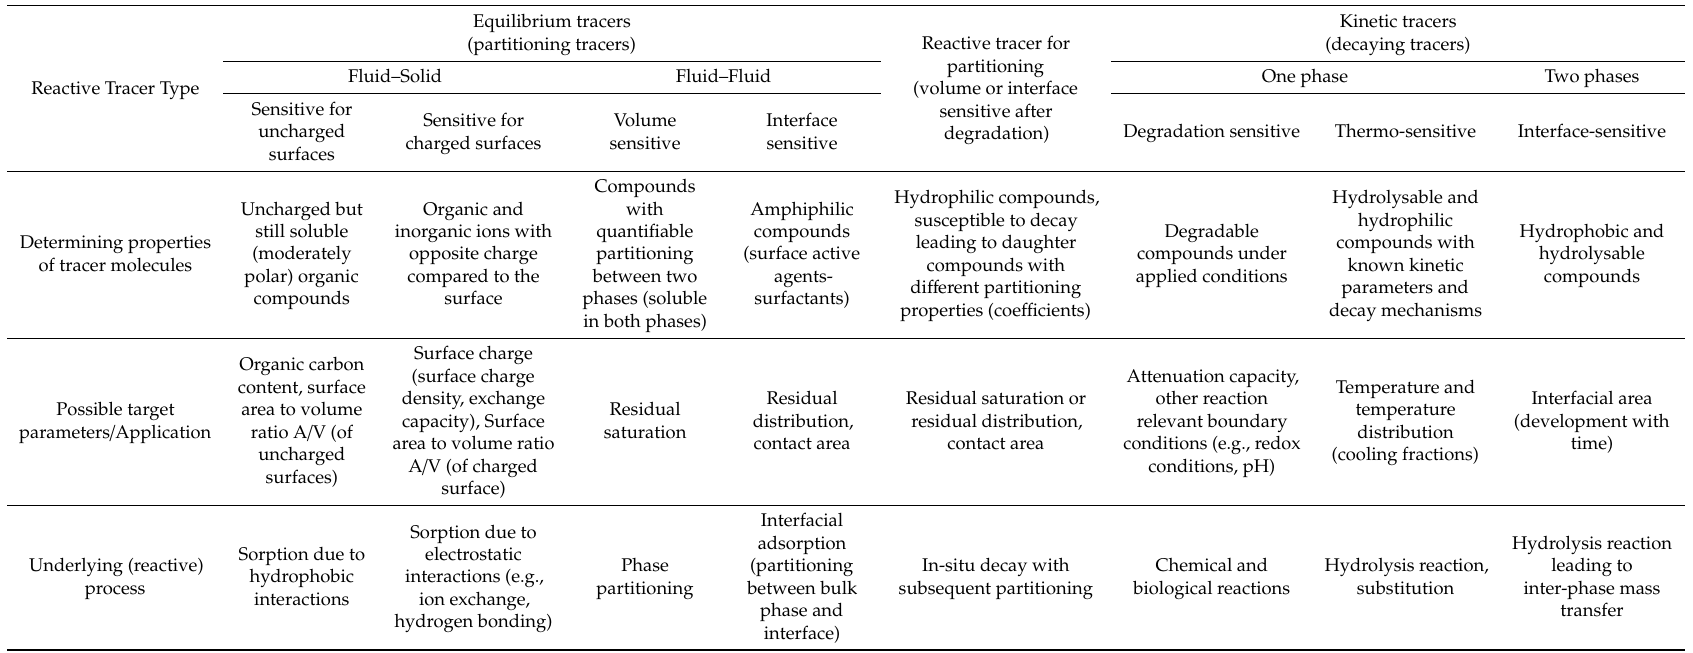
Table 1. Classification of reactive